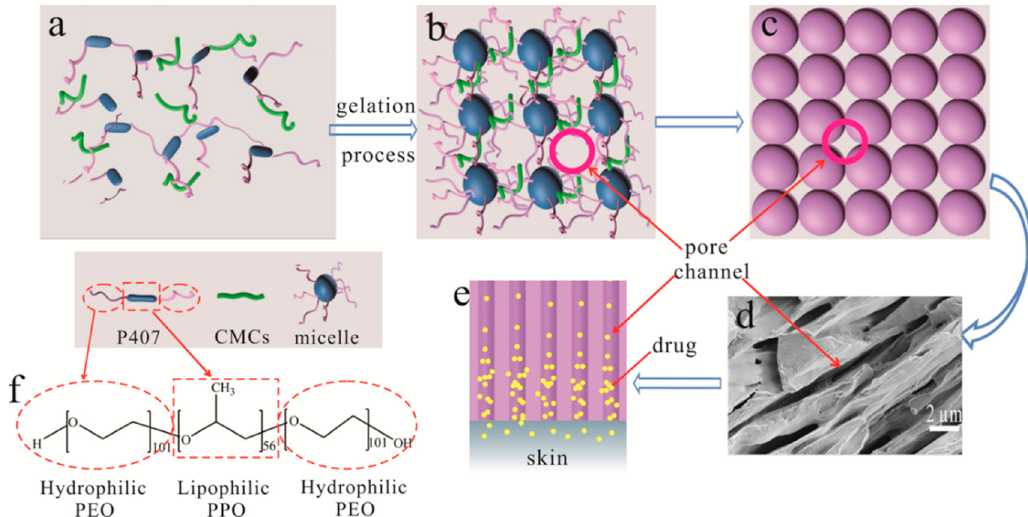
Figure 1. Schematic diagram to show the formation of pore channels based on poloxamer 407 (P407), ( a ) P407 molecule in sol state; ( b ) formation of micelles in gel state; ( c ) close-packed array model of micelles and formation of pore channels; ( d ) field emission scanning electron microscope (FE-SEM) image of sectional view of pore channels (×8k); ( e ) transport of drugs in the pore channels; and ( f ) hydrophilic poly(ethylene oxide) (PEO) chain and lipophilic poly(propylene oxide (PPO) chain of P407 molecule.